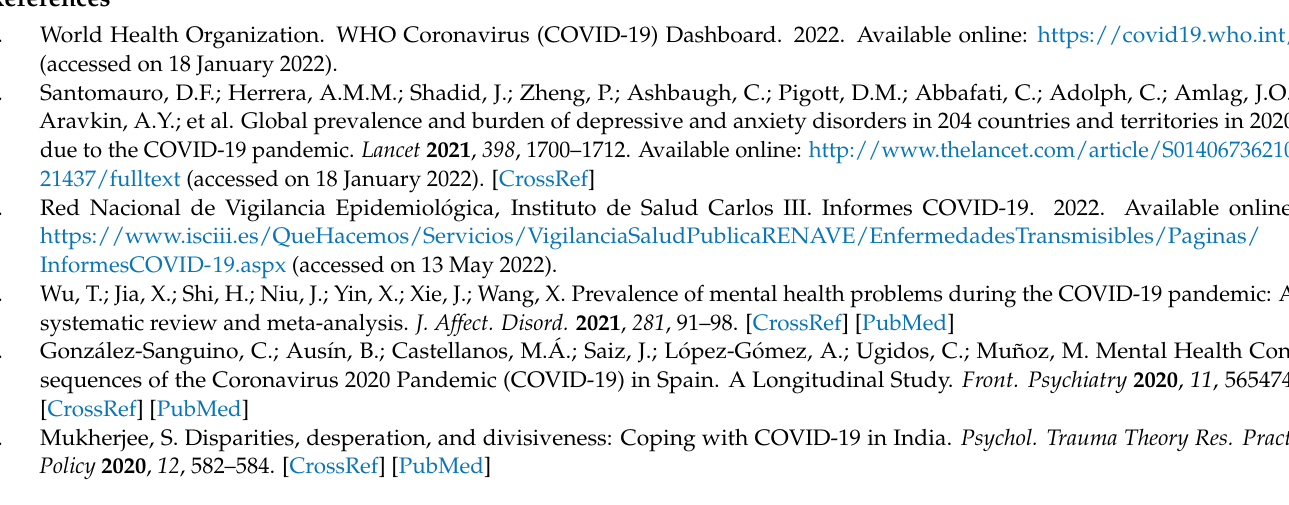
Table S4: Factors related to the social environment; Table S5: Perceived